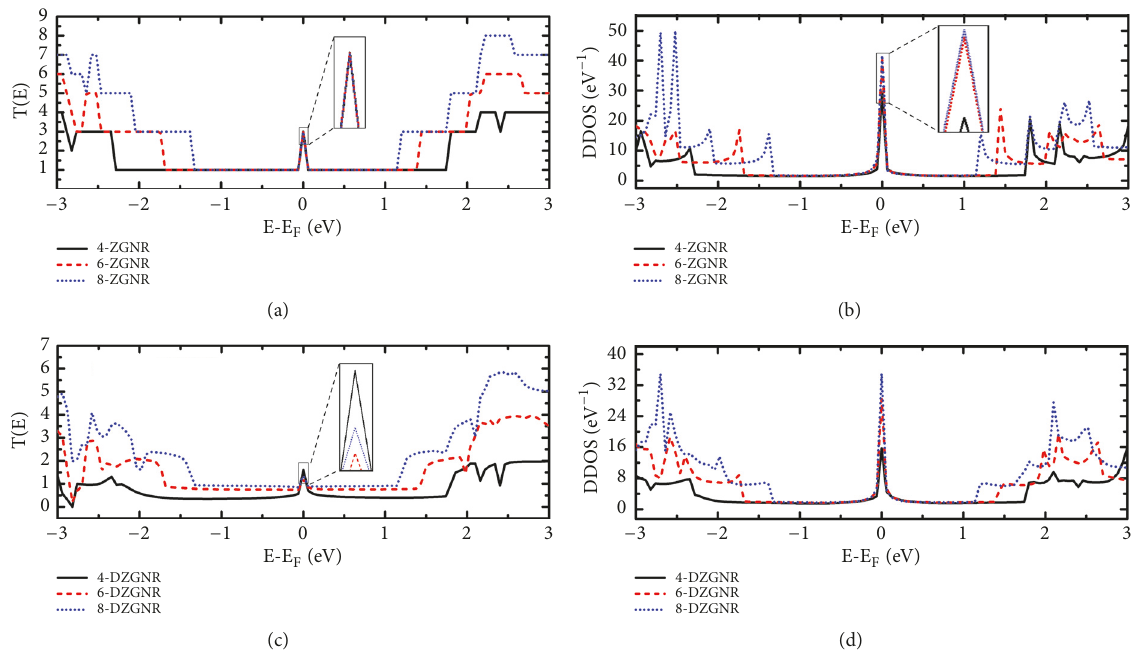
Figure 2: Transmission spectrum, T(E) ((a), (c)) and the device density of states, DDOS ((b), (d)) as a function of electron energy at zero bias voltage. The results are shown for a pristine graphene ribbon as a reference (a) and a distorted graphene ribbon (c) with four zigzag chains (solid-black curve) and for six zigzag chains (short-dashed-red curve) and for eight zigzag chains (short-dotted-blue curve) in width.